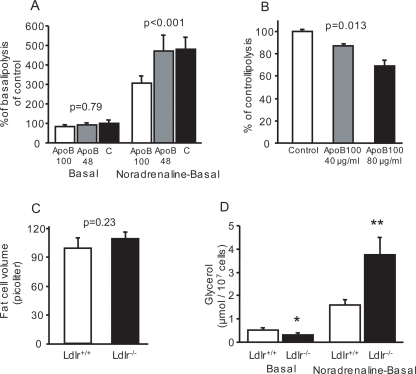
Effects of mouse apoB100 on 3T3-L1 cells and effects of Ldlr in the study mice.(A) Basal and noradrenaline-stimulated lipolysis in 3T3-L1 cells incubated with equal numbers of mouse lipoproteins containing only apoB100 (40 µg/ml medium, n = 10) or apoB48 (20 µg/ml medium, n = 4) or with vehicle alone (n = 7) for 48 hours; DF = 2,18 (p = 0.79; F-value = 0.24 for basal and p<0.001; F-value = 10.4 for noradrenaline-stimulated lipolysis). (B) Percent inhibition of lipolysis mediated by incubation of 3T3-L1 cells with mouse lipoproteins containing apoB100 at high (80 µg apoB/ml medium) and low (40 µg apoB/ml medium) concentrations or with vehicle alone (Control) (n = 9 for each concentration; p = 0.013; DF = 2,24; F-value = 5.6) for 48 hours. (C) Fat cell volume in gonadal fat pads isolated from Ldlr
−/−
Apob
100/100 mice (Ldlr−/−, n = 13) and Ldlr
+/+
Apob
100/100 mice (Ldlr+/+, n = 17) mice (p = 0.23). (D) Basal (p<0.05) and noradrenaline-stimulated (p<0.01) lipolysis in the mice described in (C). Error bars indicate SD. p-values were determined by ANOVA in (A–B) and unpaired t-test in (C–D), *p<0.05, **p<0.01 (t-test).